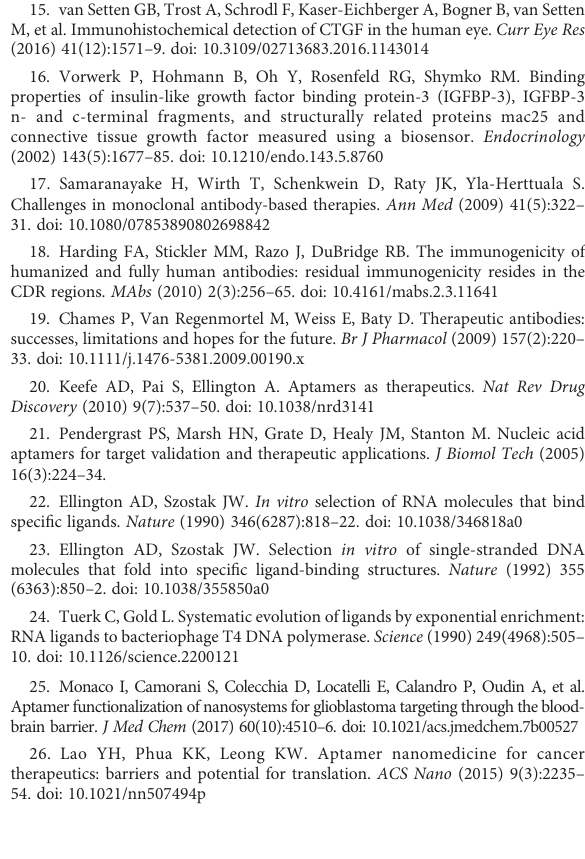
SUPPLEMENTARY FIGURE S2 Six groups of highly similar sequences sorted out from HTS analysis. SUPPLEMENTARY FIGURE S3 SPRassayof18strandsofssDNAandAptW1-2. (A) SPRassayof18strands of ssDNA. (B) SPR assay of AptW1-2 targeting CTGF. SUPPLEMENTARY FIGURE S4 Propertyassaysandfunctionalveri fi cationofAptW1-1-PEG. (A) Sensitivity assay of AptW1-1-PEG. (B) Speci fi city assay of AptW1-1-PEG. (C) Stability assay of AptW1-1-PEG incubated with plasma from healthy people. (D, E) Three-dimensional tube formation assay. HUVECs were treated with CTGF (100 ng/mL) and AptW1-1-PEG (500 nM) for 6 h. (D) Tube formation was observed and photographed. (E) The number of intersection nodes was calculated in the whole fi eld. SUPPLEMENTARY FIGURE S5 Immunogenicity assessment of AptW2-1-39-PEG. (A, B) Peripheral blood mononuclear cells (PBMCs) from healthy people were treated with AptW2-1-39-PEG (0 µM, 0.5 µM, 1 µM, and 2 µM) for 24 h. TNF- a and IFN- a in cell culture supernatants were quanti fi ed using ELISA kits. (n = 3 per group). (C) Serum total IgM and IgG levels of healthy DBA/1 mice on day 14 and day 28 after injection with APTW2-1-39-PEG. (n = 6 per group). The data are presented as mean ±